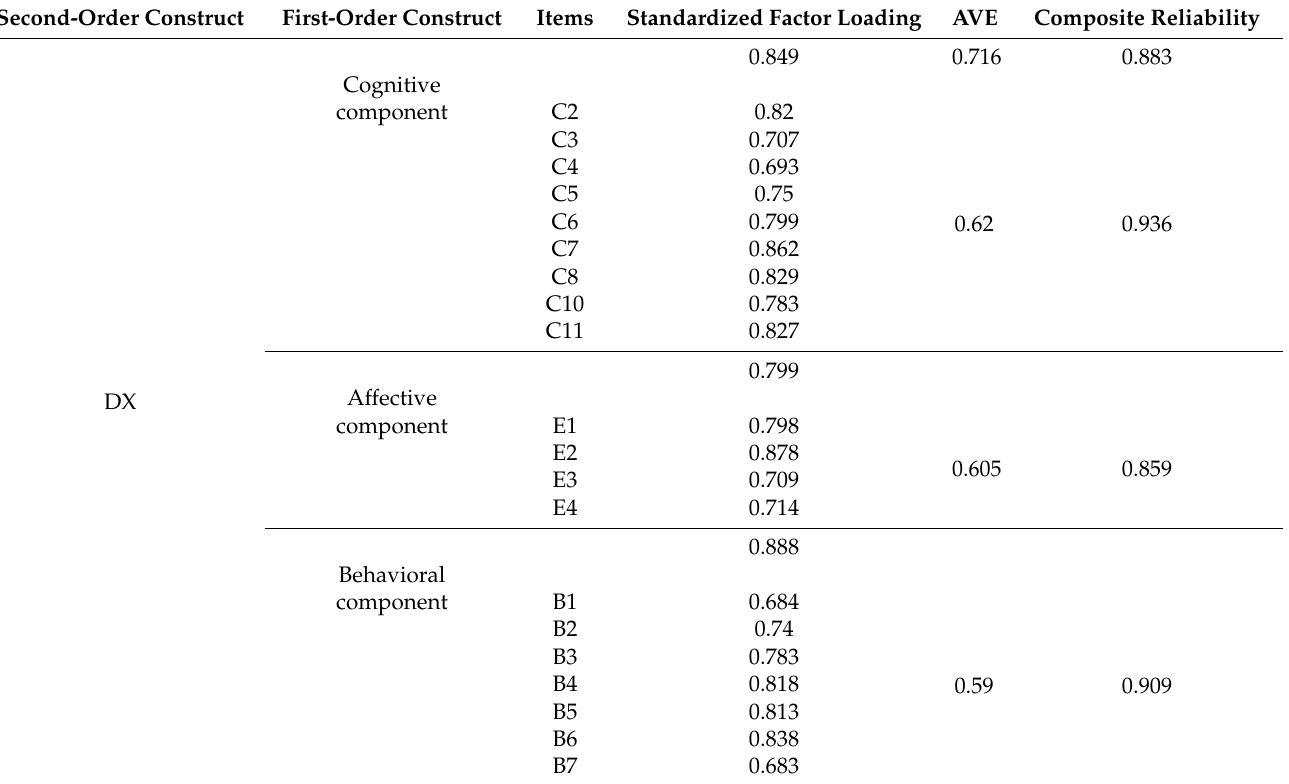
Table 7. The results of the confirmatory factor analysis.